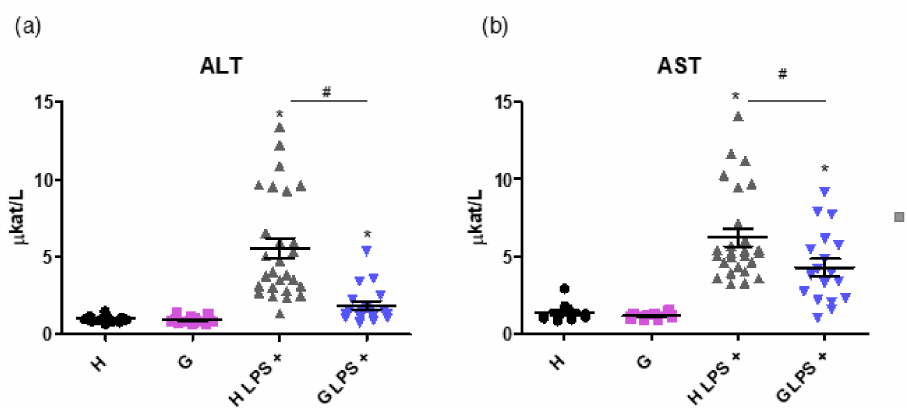
Figure 5. The e ff ect of hyperbilirubinemia and inflammation on markers of the liver injury. ALT ( a ) and AST ( b ) activities, markers of liver injury, were measured in normobilirubinemic heterozygous controls (H or H LPS + ) and hyperbilirubinemic Gunn rats (G or G LPS + ) 12 h after saline or LPS administration (6 mg / kg i.p.), respectively. * p < 0.05 vs. corresponding control, # p < 0.05 vs. LPS-treated group. n = 8 animals per group